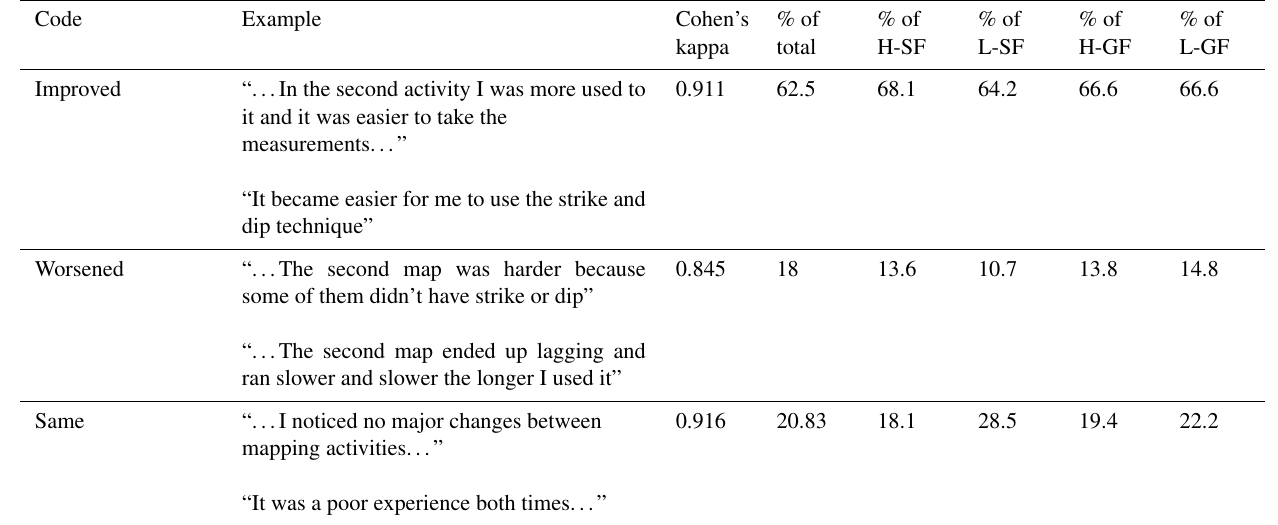
Table 7. Qualitative analysis results for the open-ended experience change across activities question.